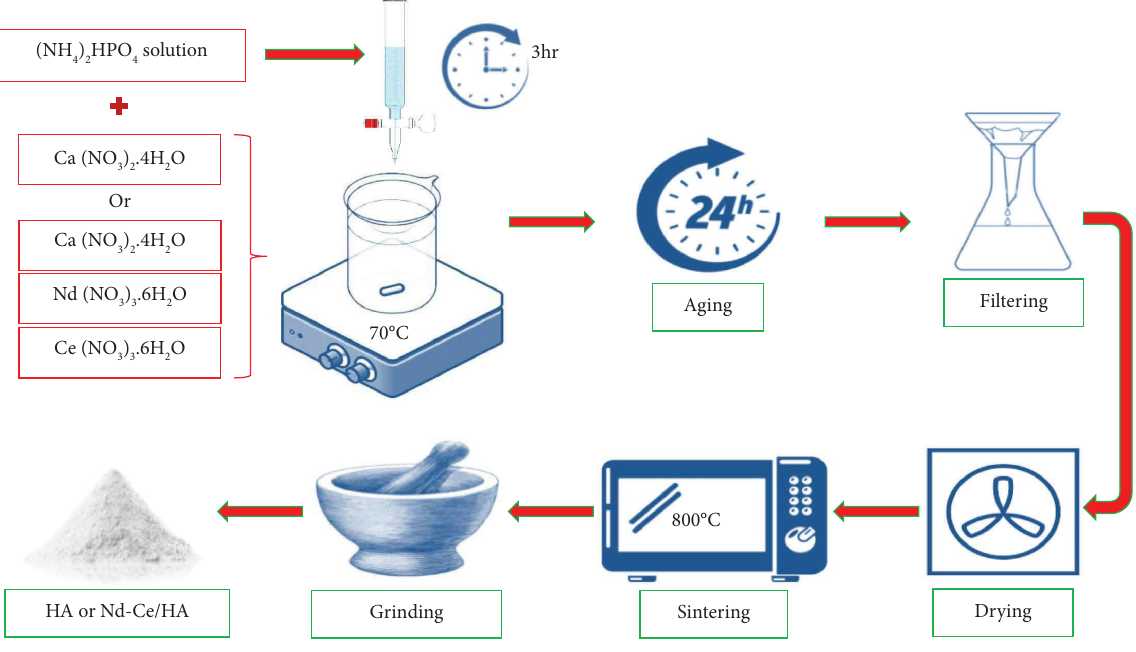
Figure 1: Preparation steps of HA and